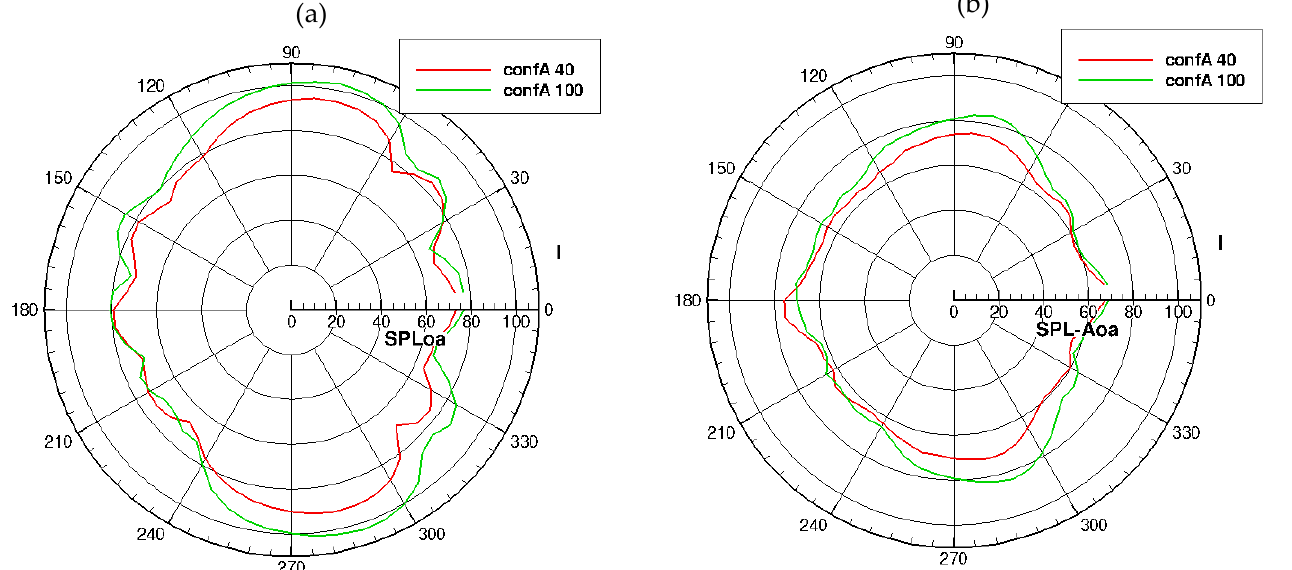
Figure 20. Configuration A, OASPL values on the horizontal XY plane ( a ), A-weighted values on ( b ). Comparison between 40% and 100% ETR.